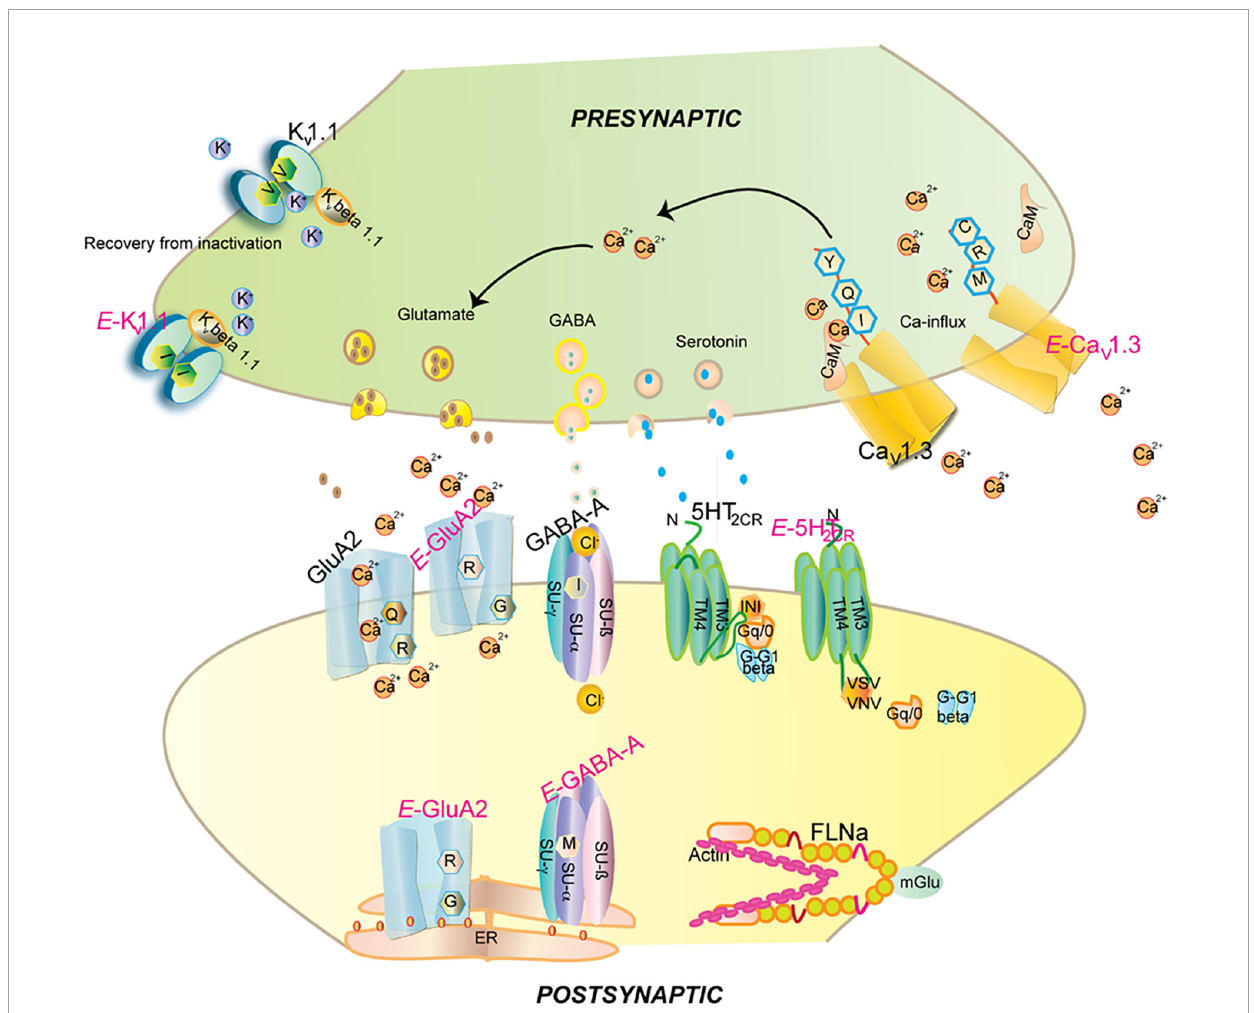
FIGURE8 Impact of editing on selected neuronal receptors and proteins. Shown are several receptors and channels in their unedited (labeled in black) and edited (E, labeled in pink) versions. Editing at the Q/R site of ionotropic glutamate receptor GRIA2 (GluA2) subunit decreases Ca2 + permeability and endoplasmic reticulum exit efficiency. Membrane trafficking of the GABA A receptor is reduced by editing of I to M in the alpha3 subunit. Editing of the serotonin 5-HT2c receptor converts the amino acids I-N-I to V-S-V, V-G-V, or V-N-V. This reduces G-protein coupling in the receptor. The editing-induced I to V exchange in the potassium voltage-gated channel KCNA1 (Kv1.1) alters the interaction with KCNB1. Editing of the IQ motif in voltage-gated calcium channel CACNA1D (Cav1.3) to MR abolishes calmodulin binding. Filamin- α (FLNA) is edited in a region that is known to interact with metabotropic glutamate receptor GRM7 (mGlu7) and some of its relatives. Figure from Tariq and Jantsch (2012), obtained under a creative commons license 3 and